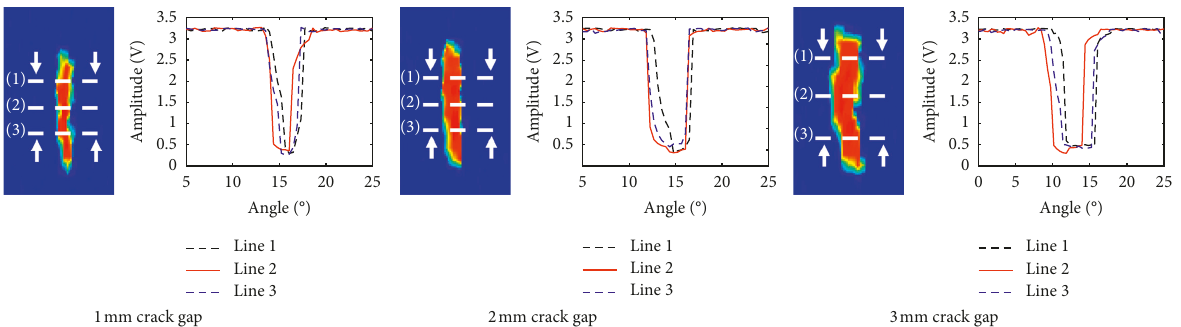
Figure 23: Inspection results for 7mm triple-type crack: C-scan (left) and cross section amplitude